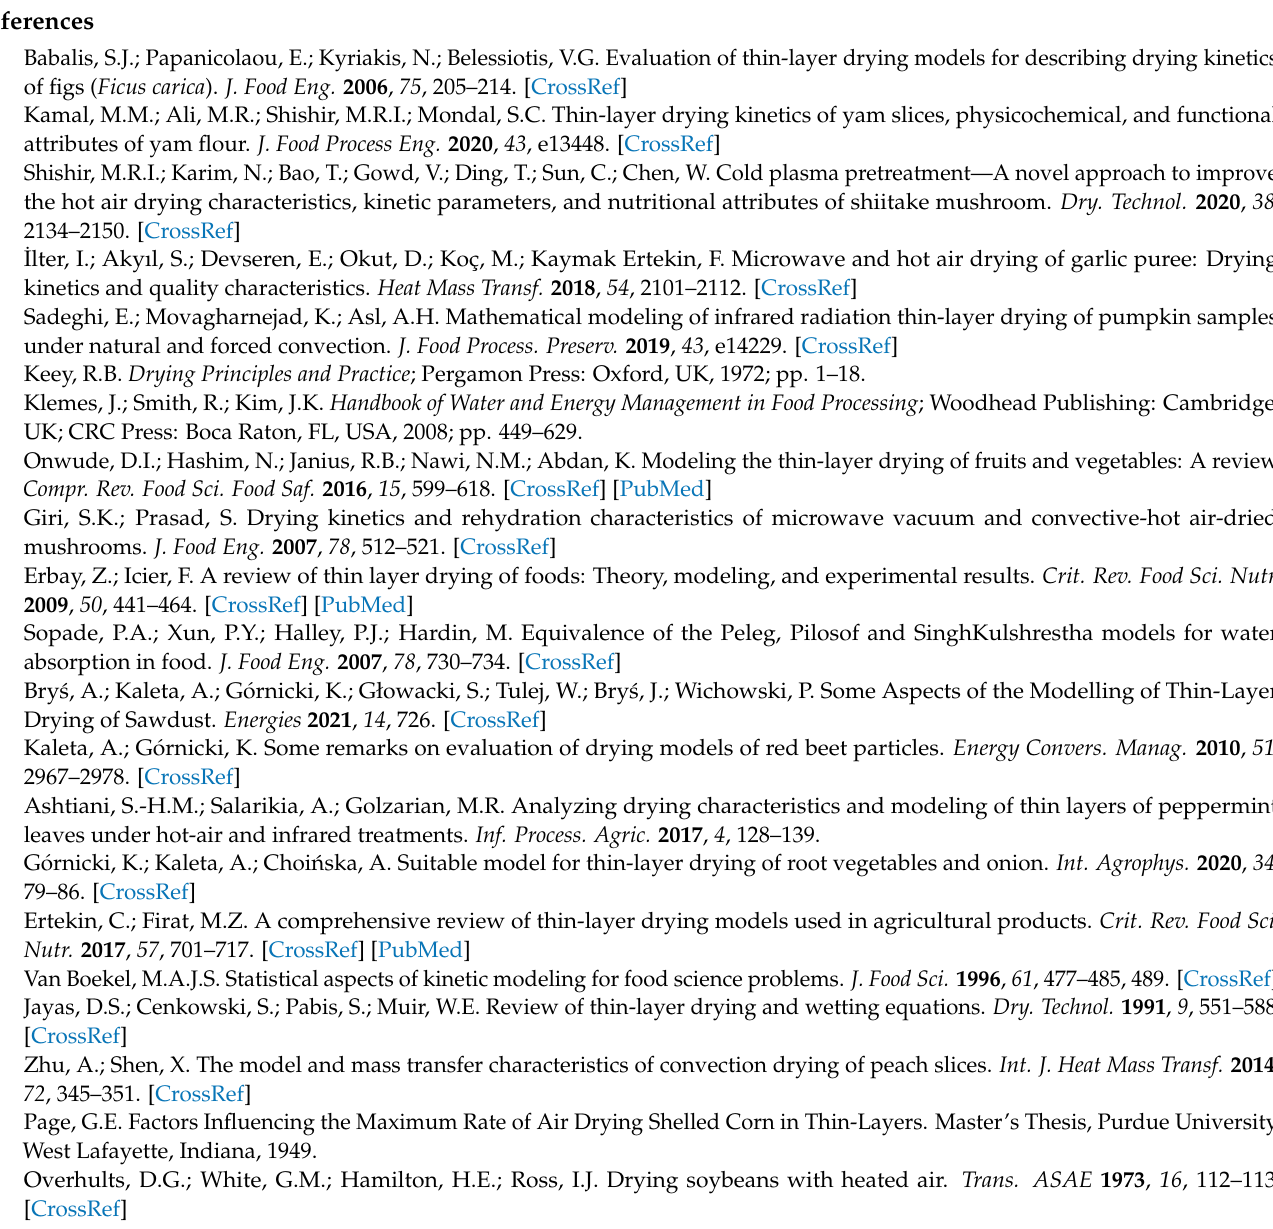
The meaning of the parameters and the effect of their values on the curve’s shape should be well known, even if the model used is an empirical